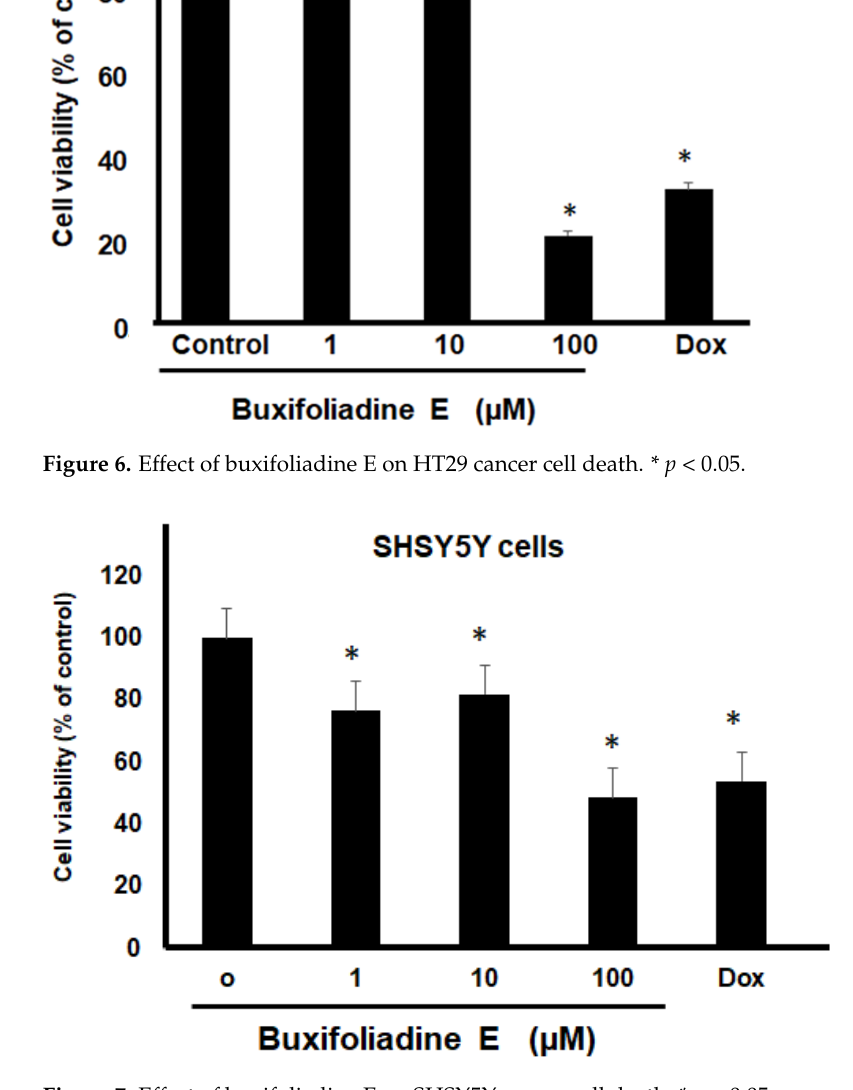
Figure 7. Effect of buxifoliadine E on SHSY5Y cancer cell death. * p < 0.05. 2.4. Effects of Buxifoliadine E on Apoptotic Signaling Proteins in HepG2 Cells